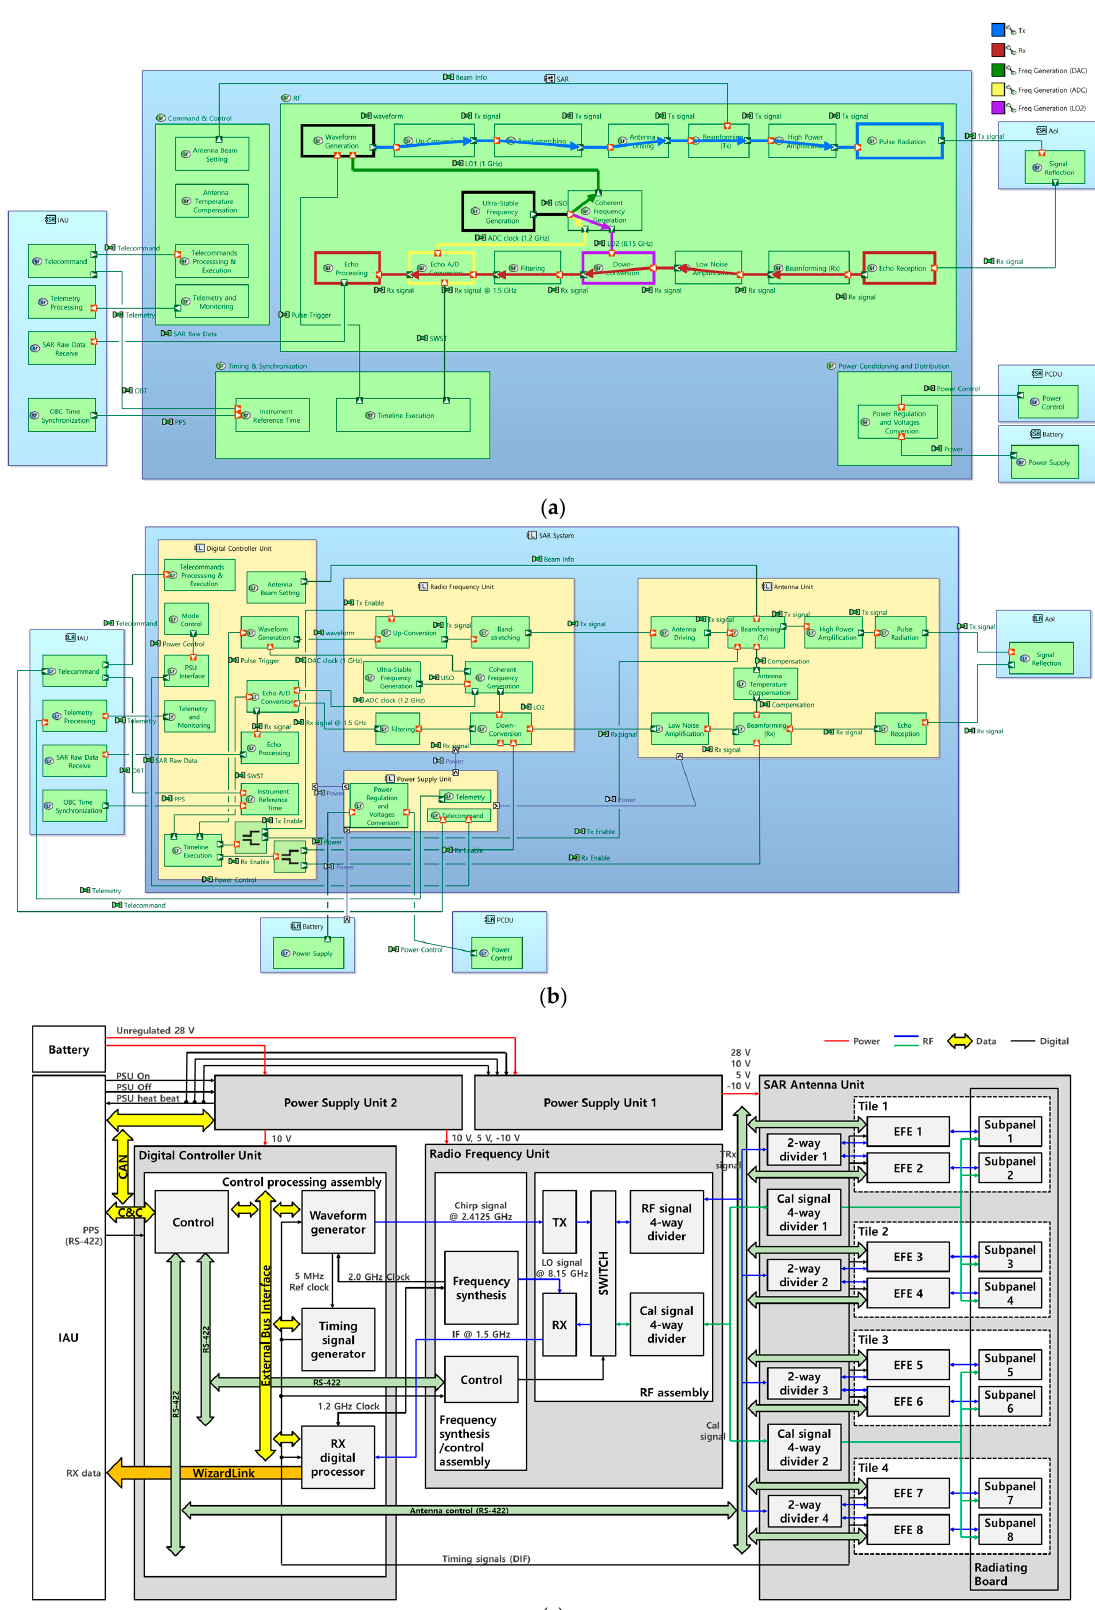
Figure 6. System architectural block diagrams of the S-STEP SAR payload: ( a ) functional architecture, ( b ) logical architecture, and ( c ) physical architecture.